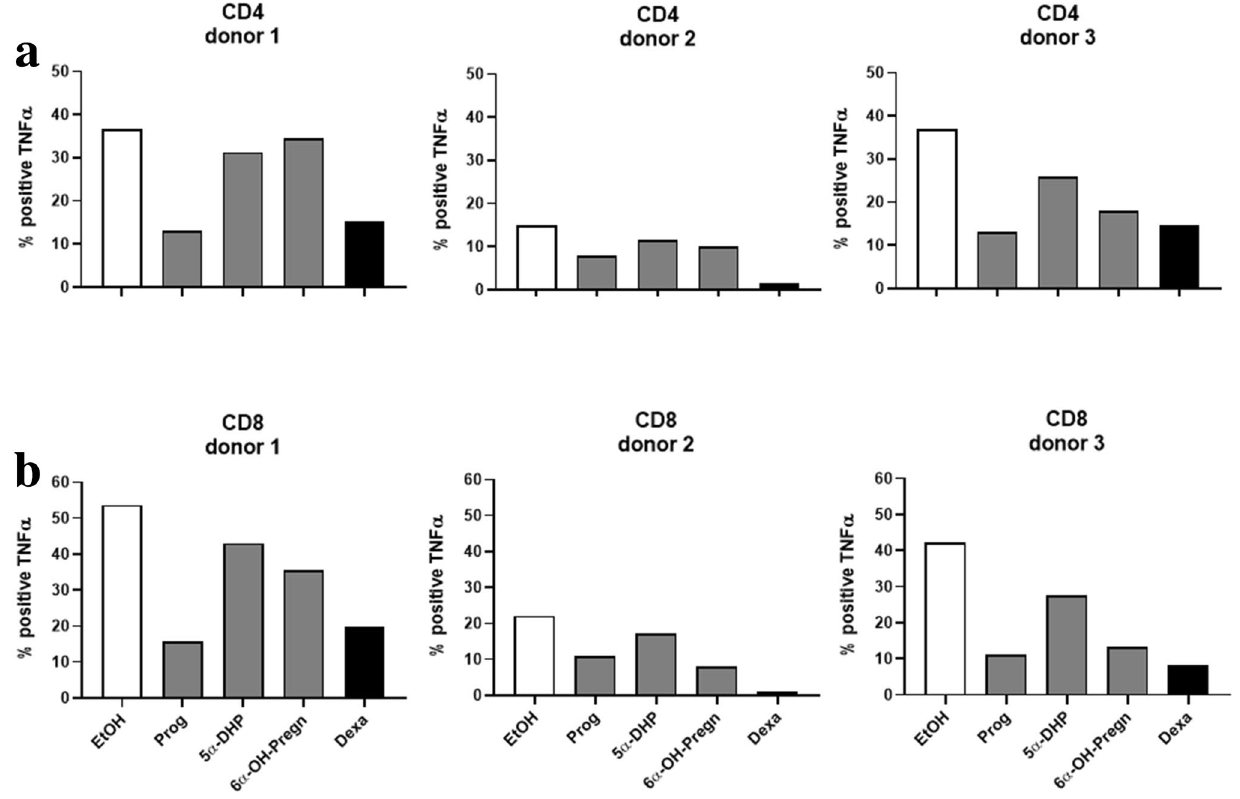
Figure 8. TNF-α production in CD4+ and CD8+ T cells upon stimulation with progesterone metabolites. Progesterone (Prog), 5α-dihydroprogesterone (5α-DHP), 6α-hydroxypregnanolone (6α-OH-Pregn) and donors for 24 h. 6 h after first steroid hormone contact, PBMCs were activated with PMA/Ionomycin. TNF-α positive CD4+ and CD8+ T cells were counted by FACS analysis. The y-axis shows the % of CD4+ ( a ) and CD8+ ( b ) T cells positively staining for TNF-α. * p < 0.05, ** p < 0.01, *** p < 0.0001, ns = not